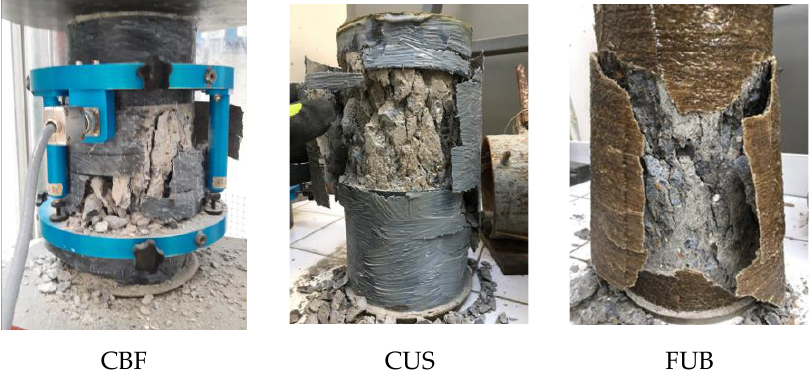
Figure 4. Failure mode of specimens.